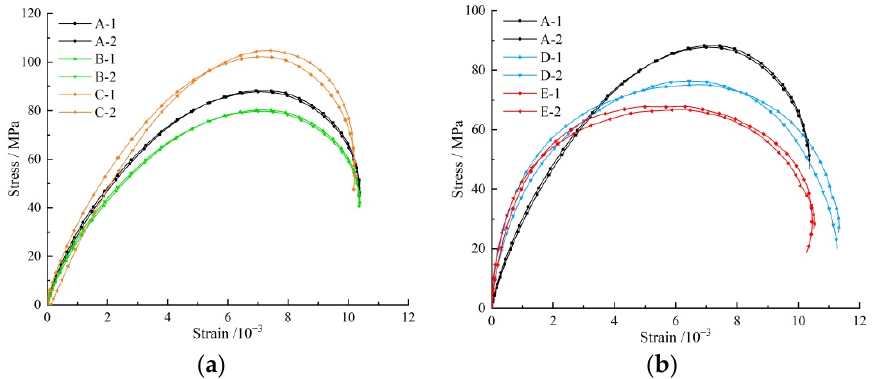
Figure 8. Stress–strain curve. ( a ) Angle between bolt and bedding; ( b ) Anchoring method. Table 3. Dynamic strength and peak strain of anchorage rock